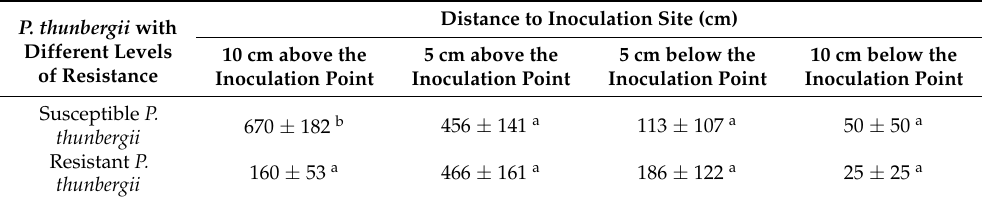
Table 1. Migration status of PWNs within P. thunbergii with different levels of resistance. The different letters above the error bars indicate statistically significant differences ( p < 0.05) as measured by Duncan’s multiple range test.